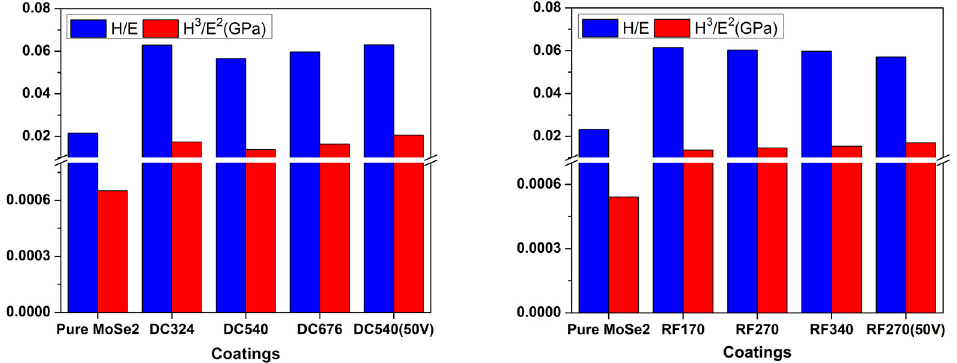
Figure 7. H / E* and H 3 / E* 2 of the coatings (case 1-left and case Figure 7. H/E* and H 3 /E* 2 of the coatings (case 1-left and case 2-right). Figure 7. H/E* and H 3 /E* 2 of the coatings (case 1-left and case 2-right).